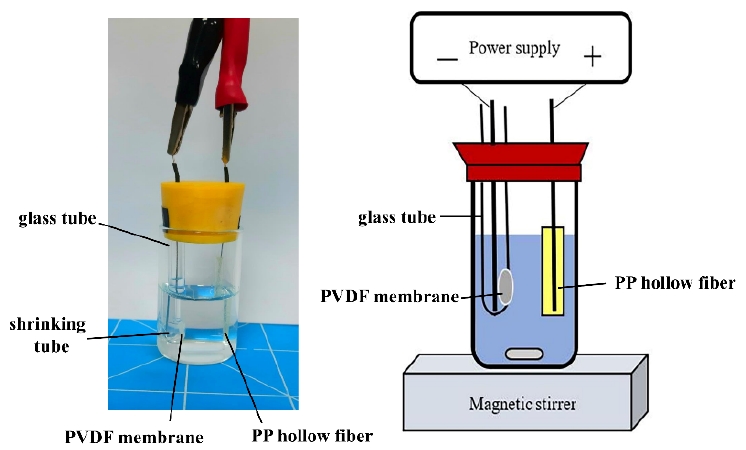
Figure 1. Schematic illustration of the EME